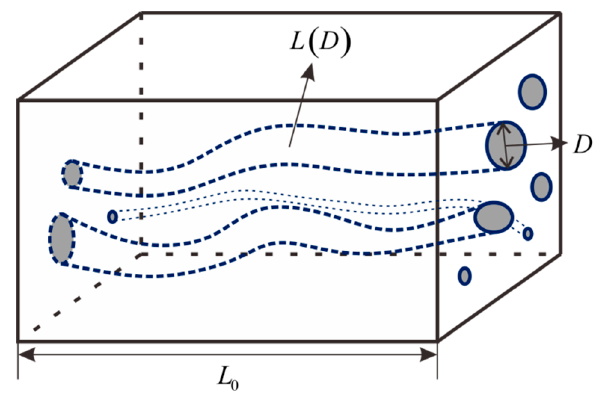
Figure 1. Shale tortuous bundle model.